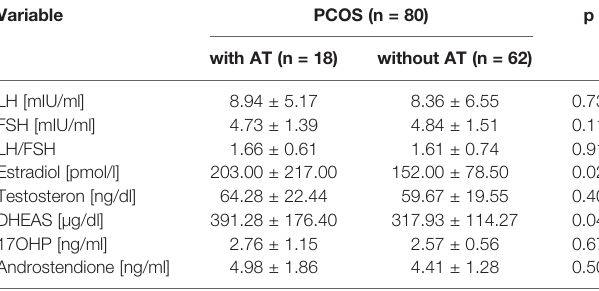
TABLE 3 | Hormonal characteristic of PCOS patients: with AT and without